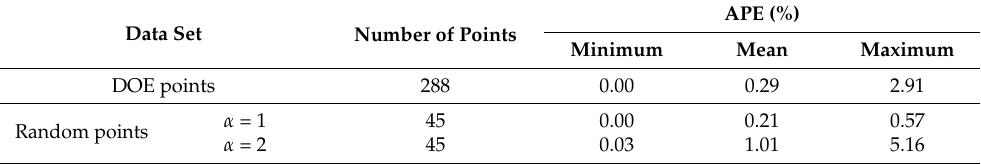
Table 8. Validation of the meta-model (strategy